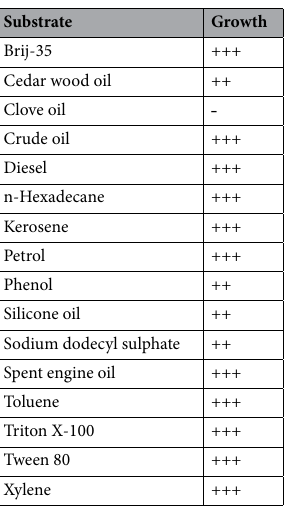
Table 1. Substrates specificity of A. sydowii BOBA1 indicates ( ˗ ) no growth, (++) moderate growth and (+++) luxuriant